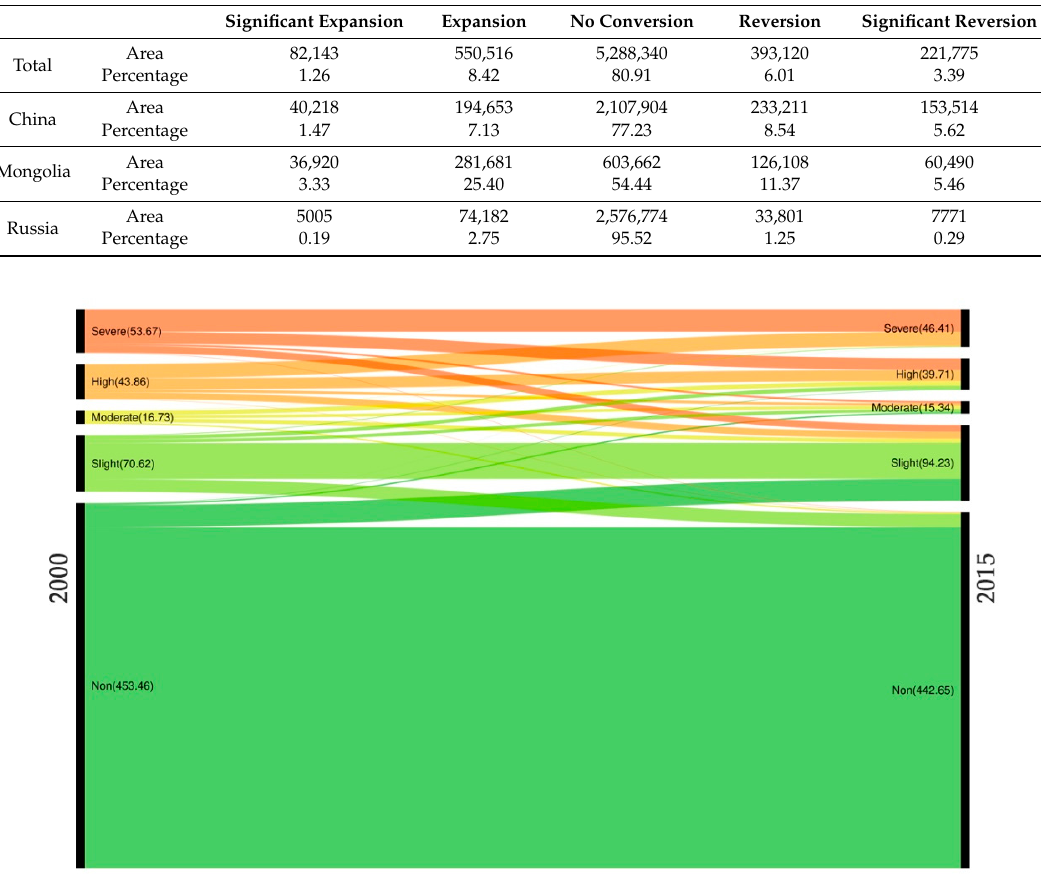
Figure 7. The spatial differences between human activities and climate change on desertification reversion ( a ) and expansion ( b ).